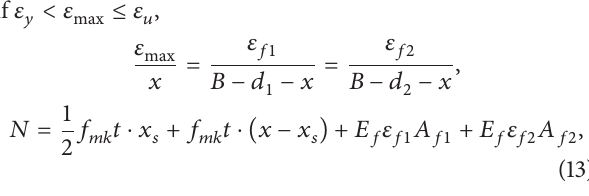
Figure7:FRP-strengthenedpanels:schemesofassemblageofframe